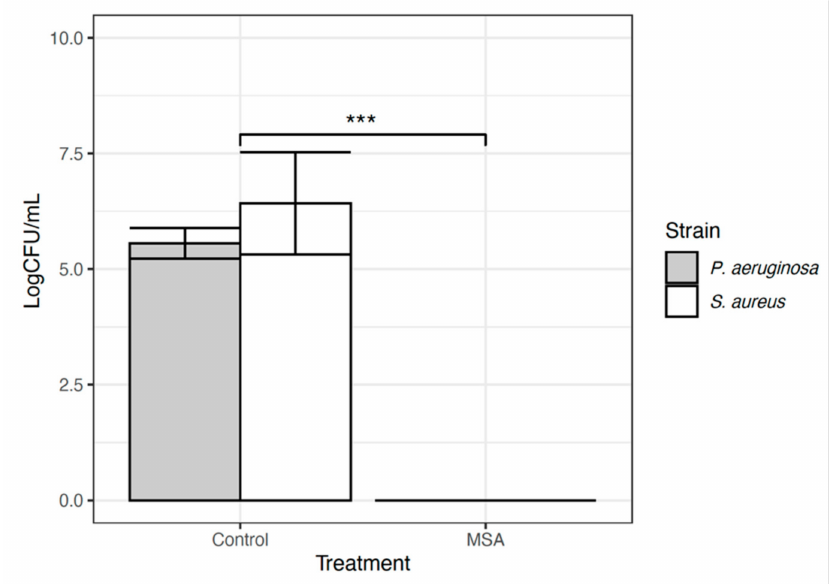
Figure 5. Results from semi solid model for P. aeuruginosa and S. aureus reported in CFU/mL. The error bars are demonstrating standard deviation. The *** demonstrates statistical significance of p <